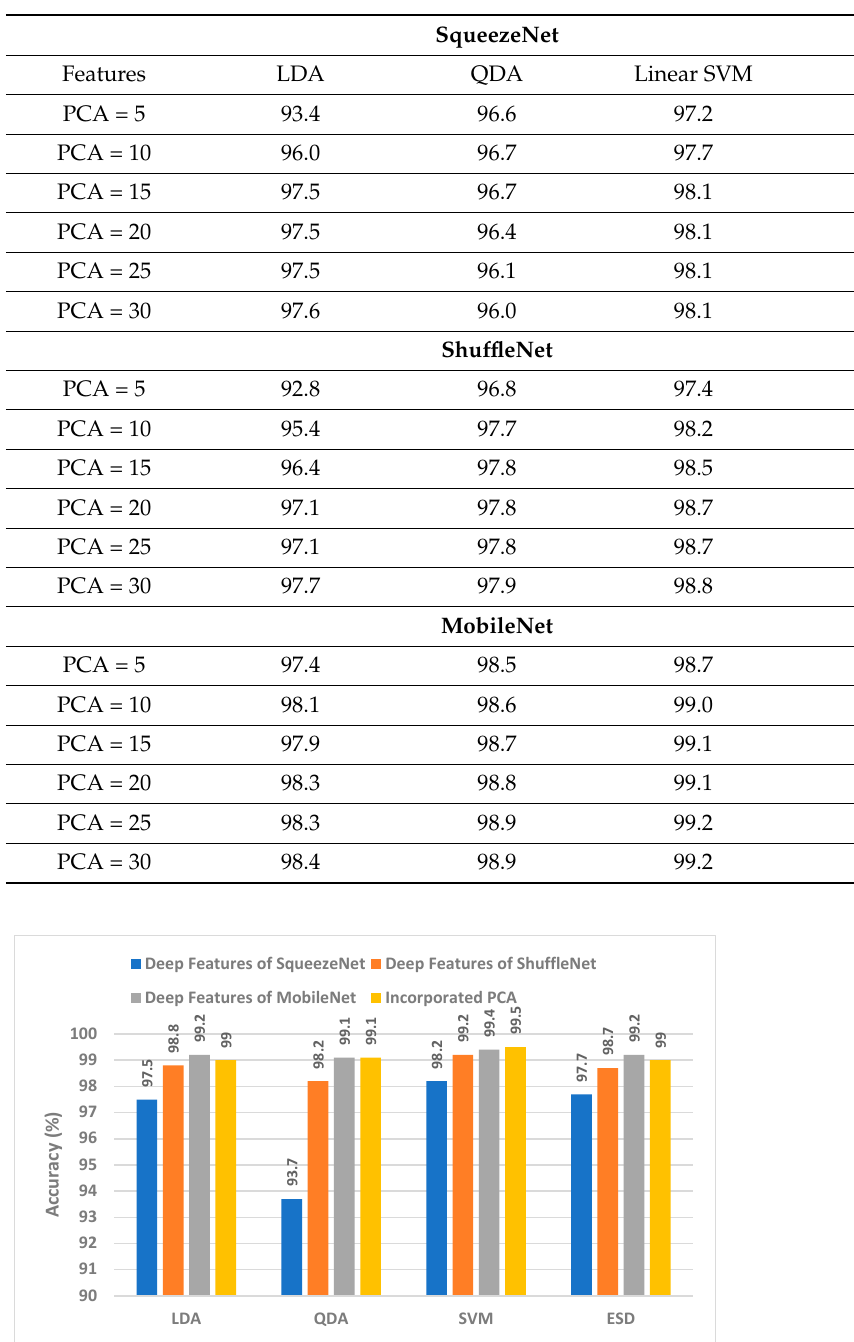
Table 1. Classification accuracies (%) for several numbers of principal components after the PCA process conducted for the deep features of the three CNNs.